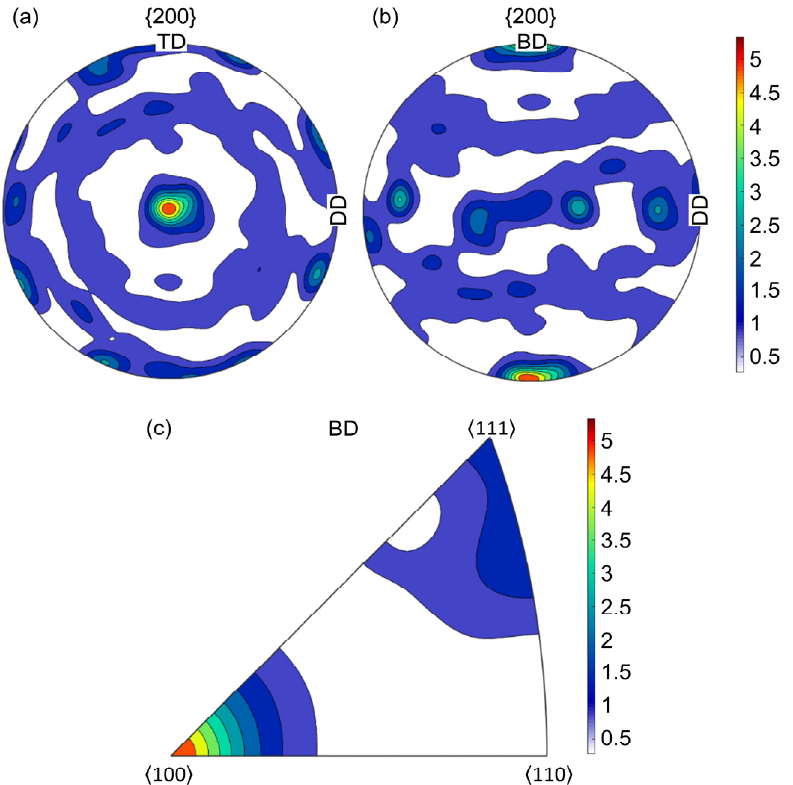
Figure 8. XRD texture analysis of the specimen prepared in the DD-TD plane; ( a ) showing the recalculated pole figure of the measured texture of the α -bcc {200} plane in BD; ( b ) recalculated and rotated pole figure of the measured α bcc {200}; ( c ) invers pole figure showing the preferred directions in BD.